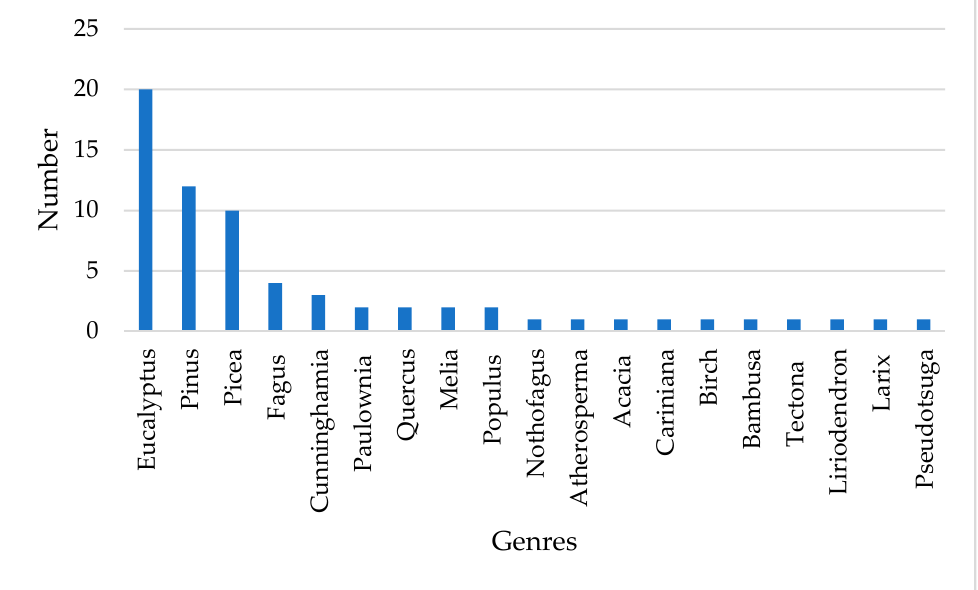
Figure 11. Used wood genera.